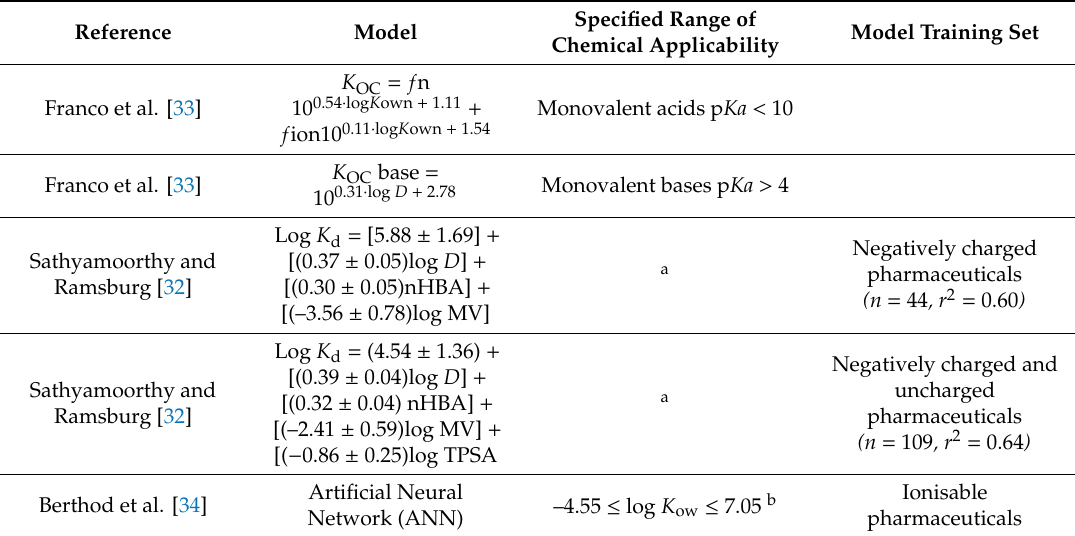
Table 2. Summary of sludge sorption models selected for